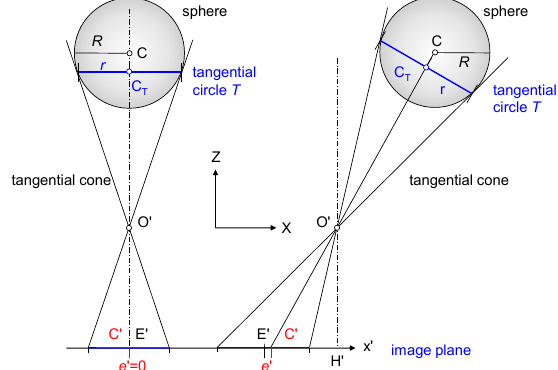
Figure 6: Eccentricity in projection of a spherical target (left: sphere on optical axis; right: sphere with lateral